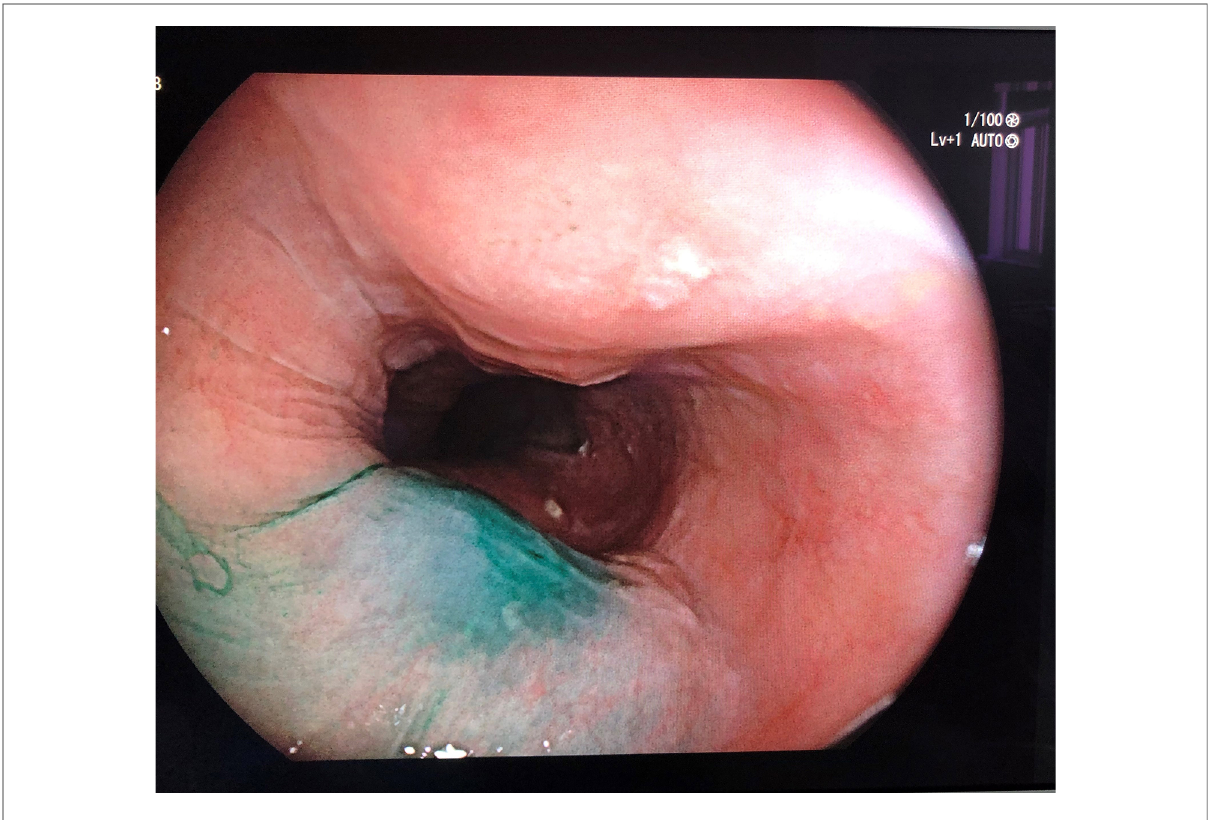
FIGURE 1 Endoscopic peritumoral ICG